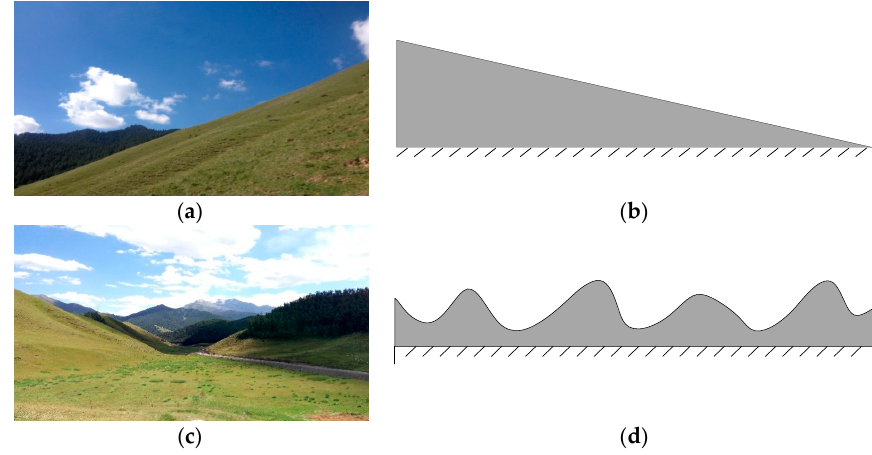
Figure 4. Graphics of topography relief: ( a ) nature surface of solo slope, ( b ) the topographic model of solo slope, ( c ) nature of composite slope, and ( d ) topographic model of composite slope.